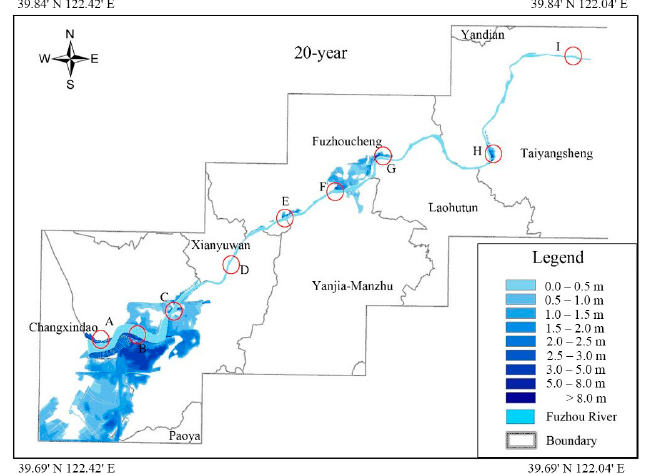
Figure 8. Flood arrival time and submerged area of 20-year return period scenario.